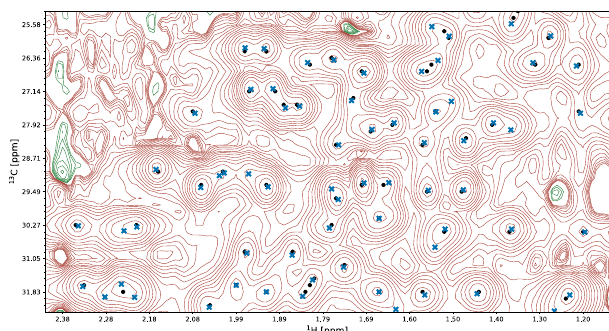
Fig. 7 | Performance of the peak picking model on a spectrum fragment with high peak overlap. A fragment of the 13 C-HSQC spectrum of protein 2K0M is shown. Initial signal positions identi fi ed by the peak picking model pp-ResNet (blackdots)aredeconvolvedbydeconv-ResNet,yieldingthe fi nalcoordinatesused for automated assignment and structure determination (blue